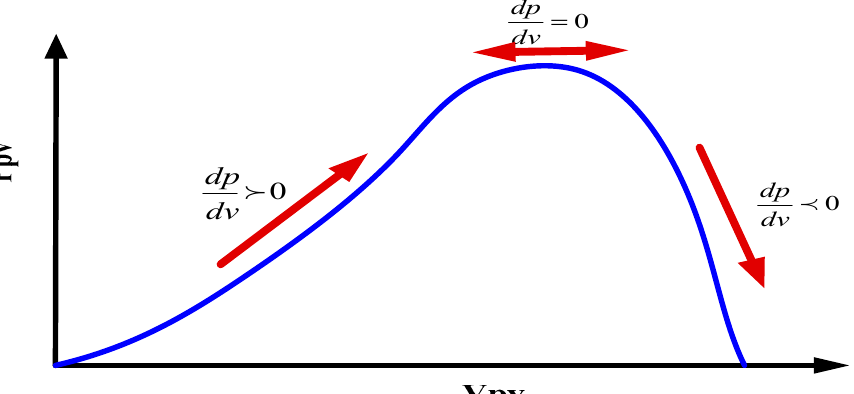
Figure 6. P-V characteristic of the PV array.